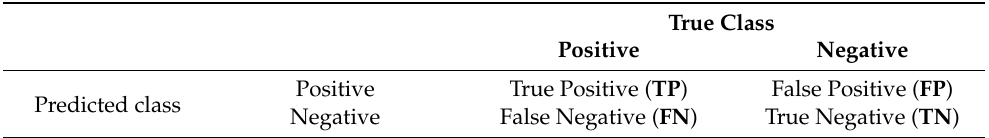
Table 2. Definitions of TP, TN, FP, and